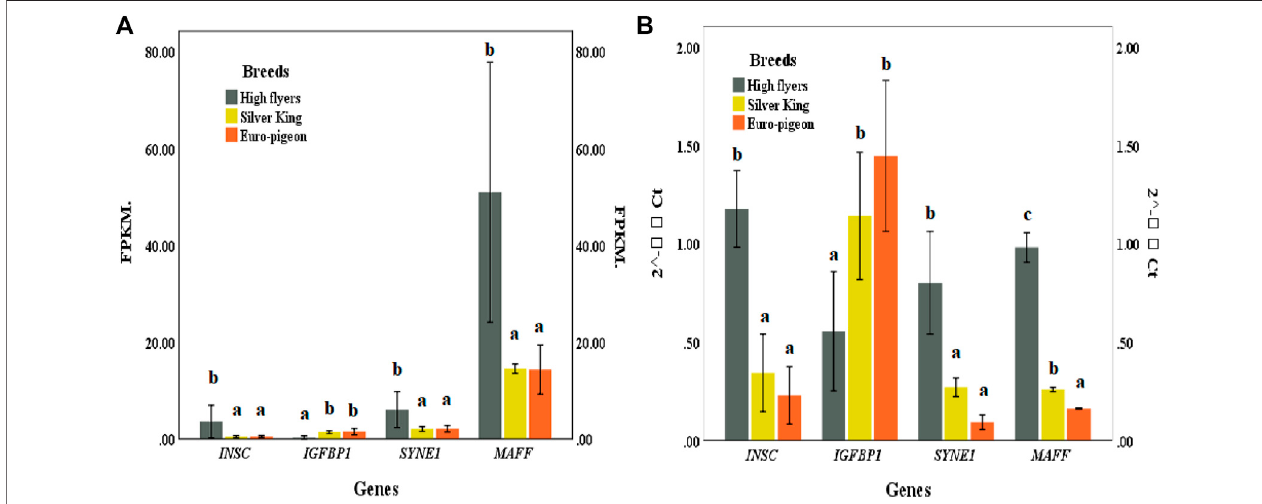
FIGURE5|(A) Geneexpressionofpigeonbreastmuscletranscriptomesequencing.FPKM(FragmentsPerKilobaseofexonmodelperMillionmappedreads). (B) Expression of fi ve signi fi cant differentially expressed genes validated by qRT-PCR. The same lowercase letters in the histogram represent no signi fi cant difference ( p > 0.05), and different letters represent signi fi cant difference ( p <